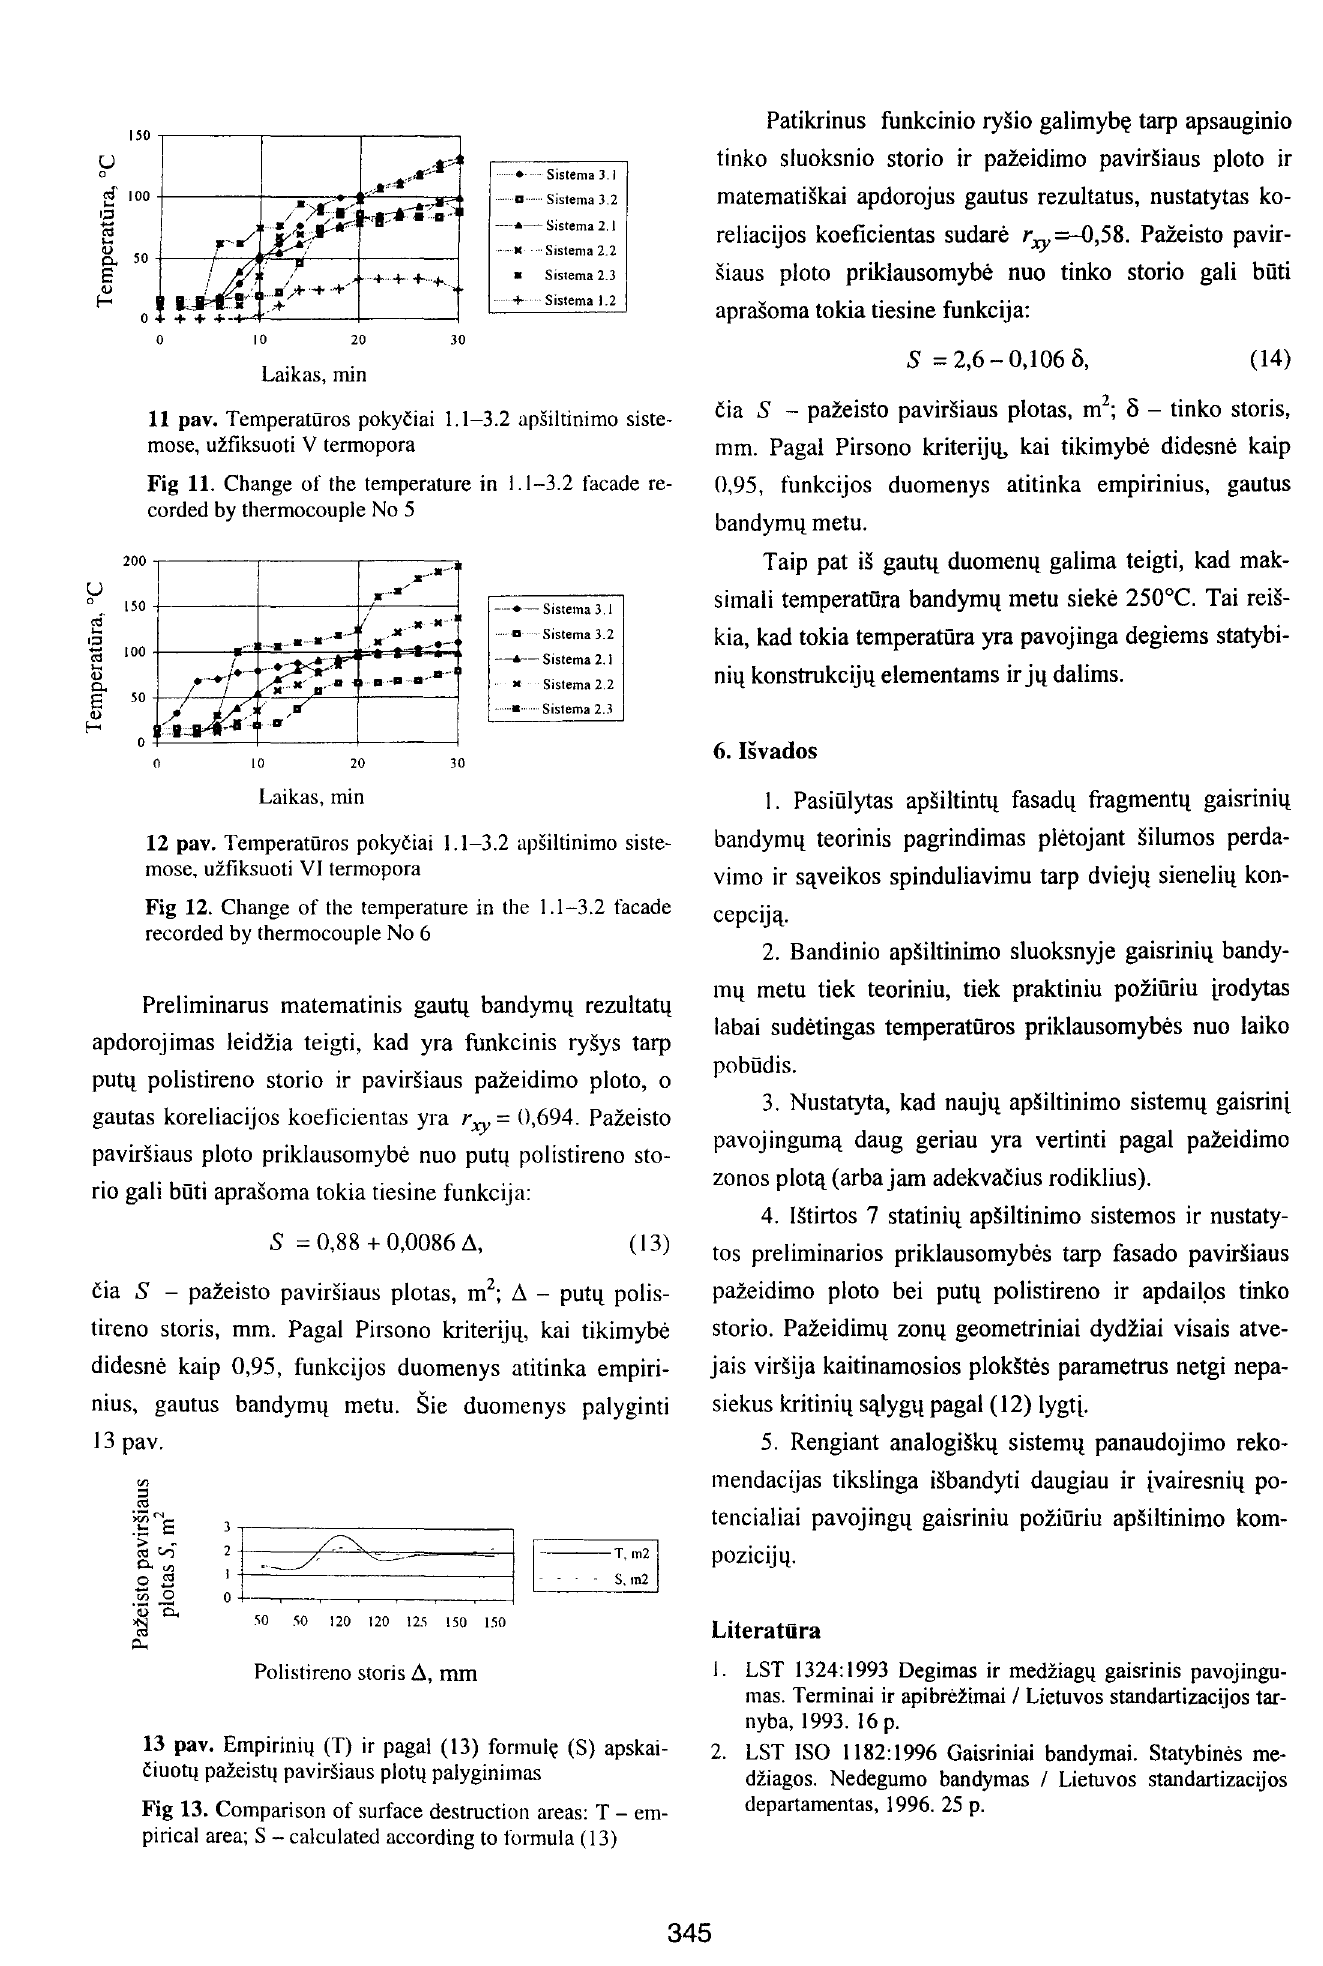
Fig 11. Change of the temperature in 1.1-3.2 facade re corded by thermocouple No 5